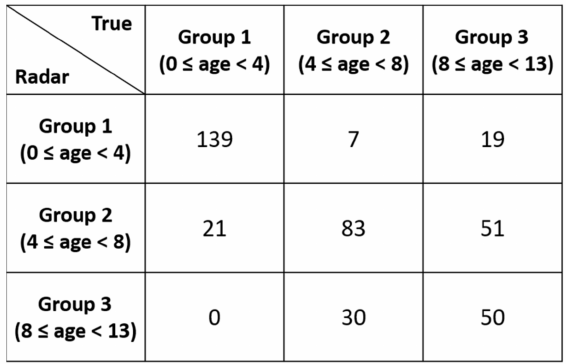
Figure 9. Confusion matrix of the 3 age-group classification.